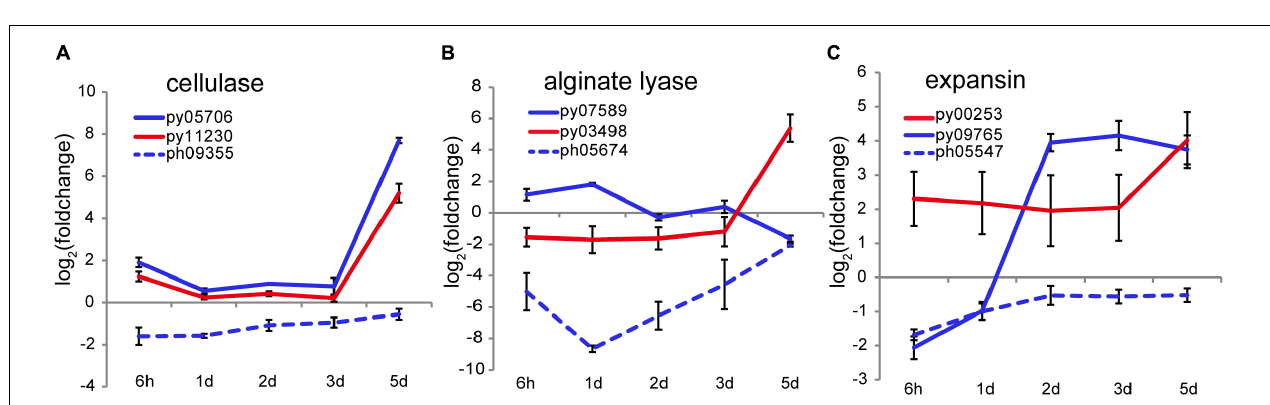
FIGURE 4 | Cell cycle progression during wound-induced spore formation. (A) S-phase cells stained by EdU in the cut fragments along the time course. Fluorescence at the edge of fragments on 3–5th days are remaining reagents. Bars represent 50 µ m in each panel. (B) Transcriptional variations of DNA-replication related genes in N. yezoensis . The red line represents the mean values of log 2 (foldchange) of all the related genes, and the bars indicate standard errors. (C) Same plot as 4C but for N. haitanensis . (D) Transcriptional variation of TOR genes in the two Pyropia species. (E) Cellular changes in a N. yezoensis thallus fragment treated with rapamycin. (F) Transcriptional variation of three cyclin genes in N. yezoensis . The dashed line in blue was the N. haitanensis ortholog of py02624. The plots in (D,F) were done as described in Figure 2C .